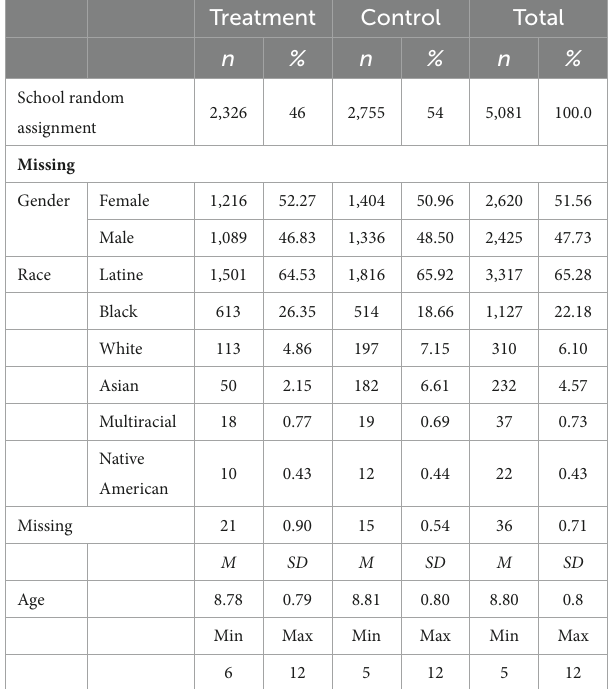
TABLE 2 Child demographic